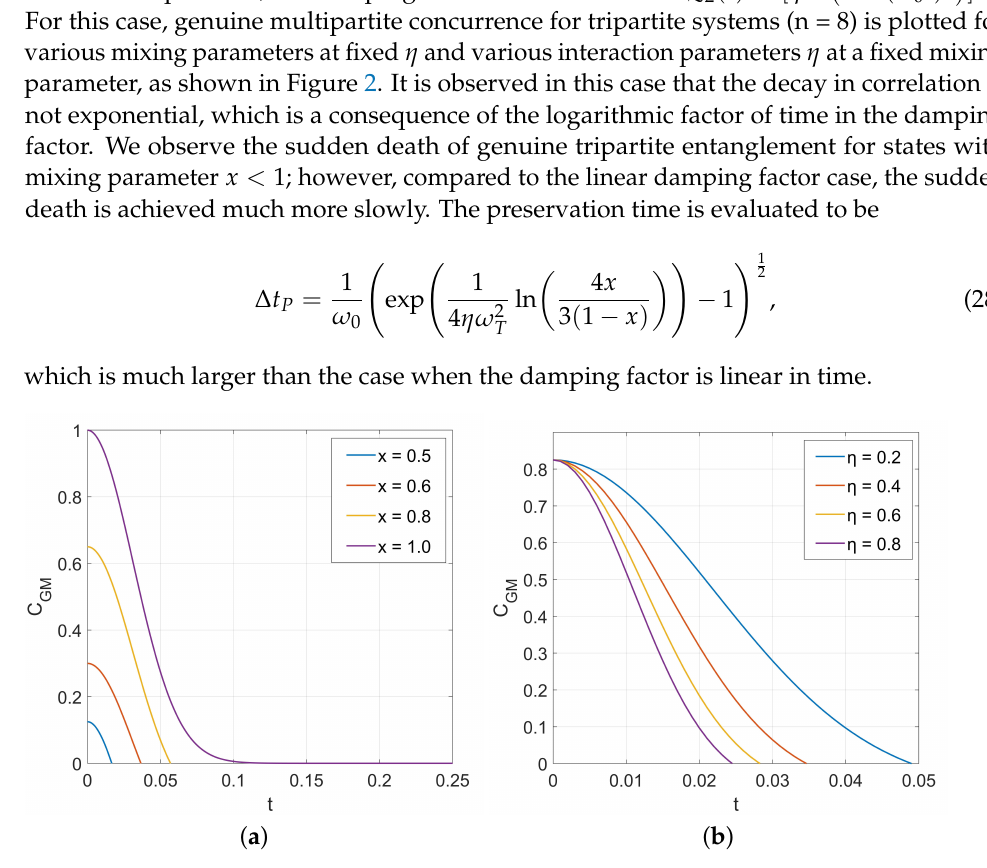
Figure 2. Genuine multipartite concurrence plotted against time (in units of ( ω 0 ) − 1 ) for ohmic spectral density at zero temperature (for n = 8). ( a ) For various mixing parameters at fixed η ( b ) for various interaction parameters η at a fixed mixing parameter x = 0.9. Entanglement sudden death is observed for x < 1; however, the decay rate is slower in this case than the exponential decay for the linear damping parameter